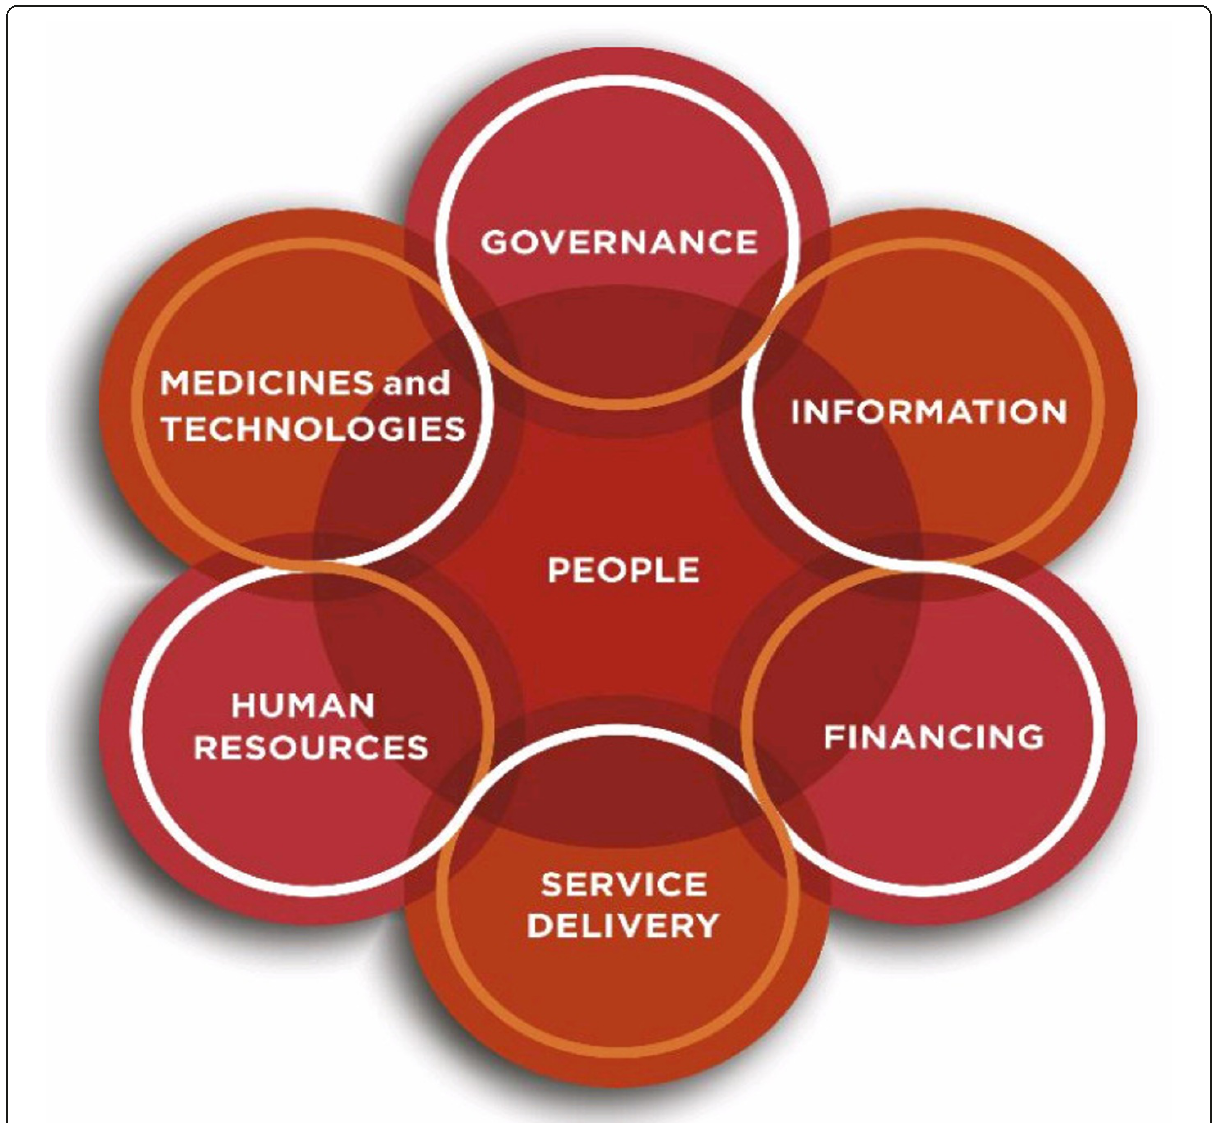
Figure 1 Major interdependent health system building blocks. Reproduced with permission from de Savigny and Adam (2009)